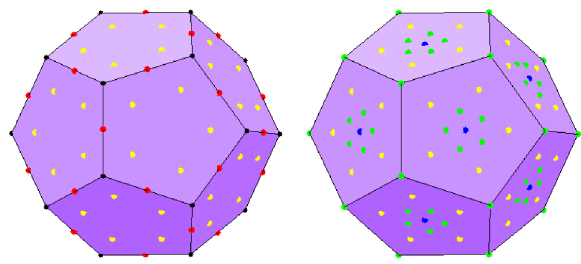
FIG. 2. Alice’s optimal cheating ensembles for n ¼ 10 and (cid:2) 2 ½ 0 : 2 ; 0 : 5 (cid:5) . This figure shows, in Bloch space, the directions of the states in Alice’s optimal cheating ensembles that set the bound C n ð (cid:2) Þ for EPR-steering when (cid:2) 2 ½ 0 : 2 ; 0 : 3 (cid:5) (on the left) and when (cid:2) 2 ½ 0 : 3 ; 0 : 5 (cid:5) (on the right), for the exemplary case of n ¼ 10 . The black dots (visible only on the left) define Bob’s measurement axes: the vertices of the dodecahedron. For the deterministic strategy where Alice gives non-null results for only two of Bob’s settings ( m ¼ 2 ), the red dots (on the left) define the optimal states that Alice should send, and likewise for m ¼ 3 (yellow; both images), m ¼ 4 (green; right), and m ¼ 5 (blue; right). For any heralding efficiency 0 : 2 < (cid:2) < 0 : 3 (left), Alice’s optimal strategy is nondeterministic: a mixture of the (cid:2) ¼ 0 : 2 strategy (red) and the (cid:2) ¼ 0 : 3 strategy (yellow). For any 0 : 3 < (cid:2) < 0 : 5 (right), a dishonest Alice should use a mixture of the (cid:2) ¼ 0 : 3 (yellow) and (cid:2) ¼ 0 : 5 (blue) strategies. Interestingly, the m ¼ 4 (green) deterministic strategy is never used; this is seen also in Fig. 3 (where the corresponding point does not lie on the curve representing the optimal strategy).